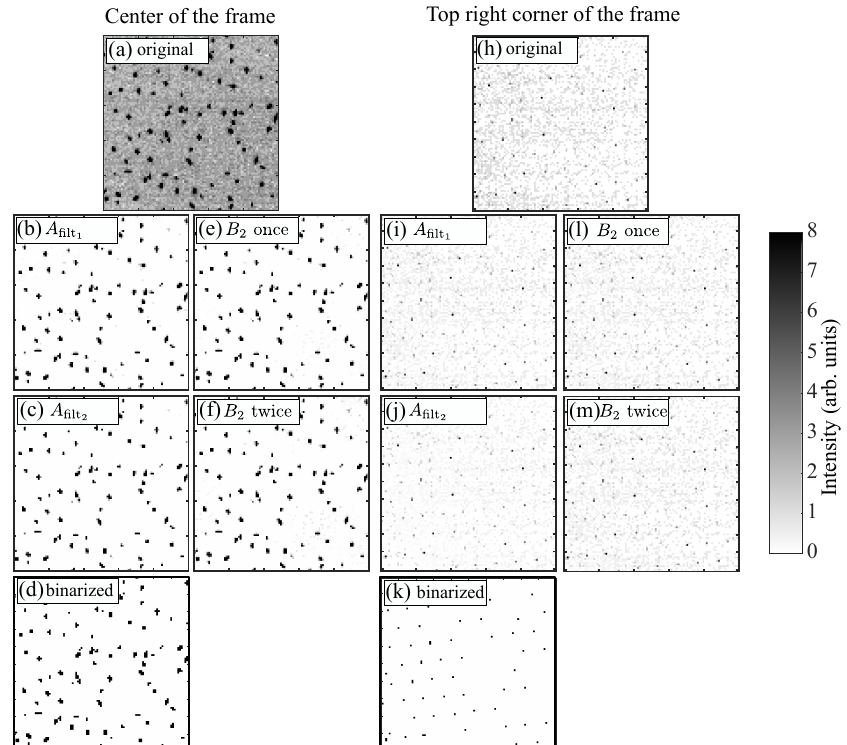
Figure 3. ( a , h ) Zoom of the raw original frame shown in Figure 2 in the centre and at the top right corner, respectively. Note that the grey scale of the original image has been changed from 0–255 to 0–8 for better visibility (pixels artificially saturate if their intensity is greater than 8). ( b , i ) Respective zooms of the frame after removal of the background obtained by blurring the original frame using a Gaussian filter having a width σ = 50. ( c , j ) Respective zooms of the frame after the second-pass background removal obtained by blurring the images in (b,i) using a Gaussian filter having a width σ = 10. ( d , k ) Binary images obtained after thresholding the images in ( c , j ) with a threshold value of 1.8. ( e , l ) Respective zooms of the frame after removal of the background obtained by blurring the original frame using a Gaussian filter having a width σ = 10. ( f , m ) Respective zooms of the frame after the second-pass background removal obtained by blurring the images in ( e , l ) using a Gaussian filter having a width σ =